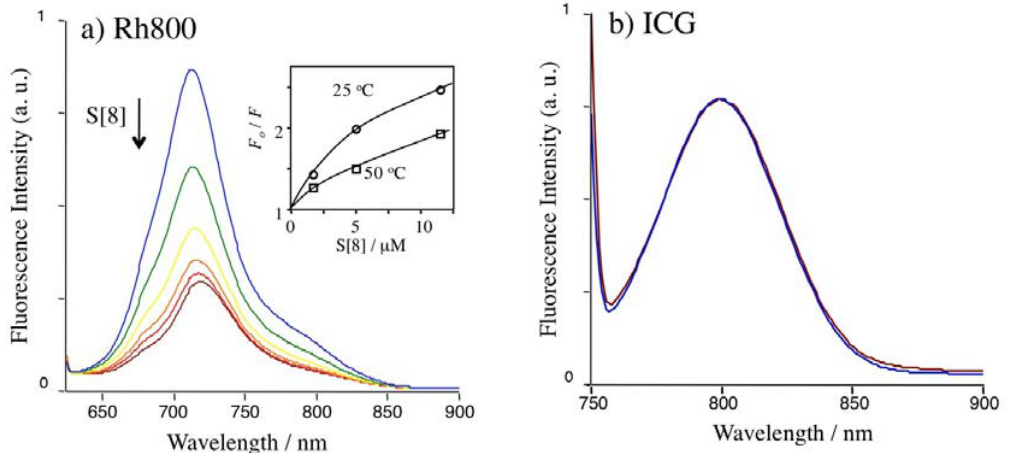
Figure 2. Fluorescence spectra of Rh800 (a) and ICG (b) upon adding S[8] in PBS. The concentration of Rh800 and ICG was 40 nM. Excitation wavelengths were set to 600 nm for Rh800 and 725 nm for ICG. [S[8]] = 0  M (blue line), 1.7  M (green line), 5.0  M (yellow line), 11.5  M (orange line), 24  M (red line), and 52  M (brown line).